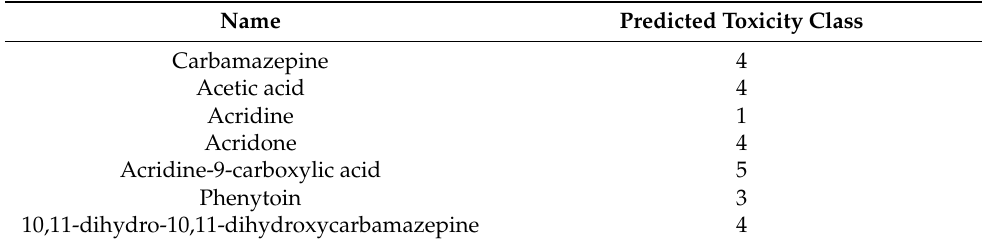
Table 3. The toxicity of carbamazepine and by-products.